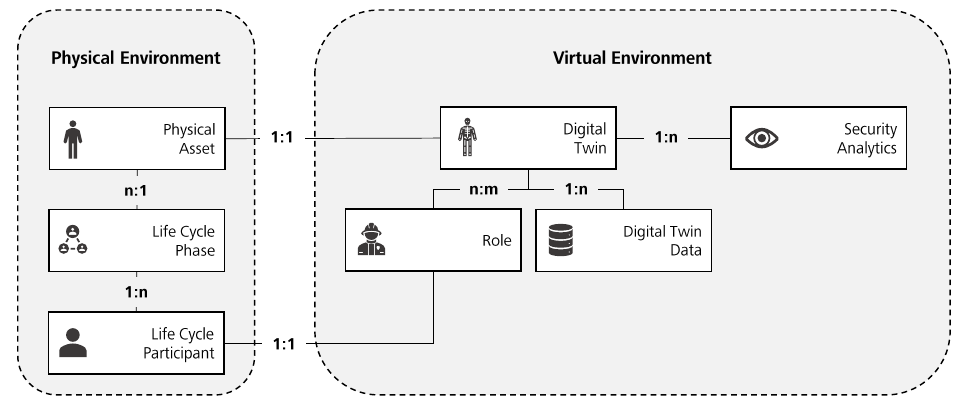
Figure 3. Security analytics through the intertwining of physical assets and digital